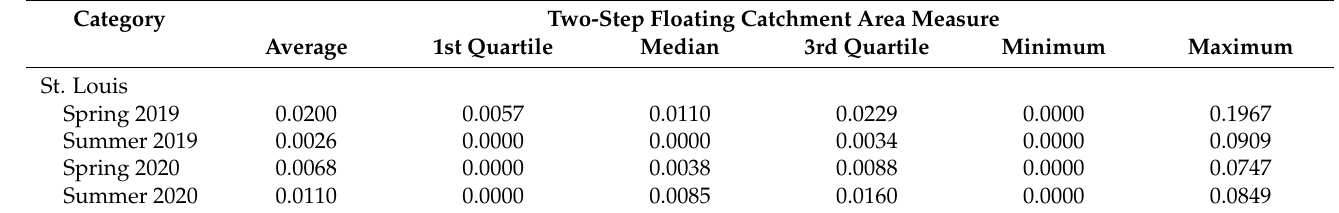
Table 4. Accessibility